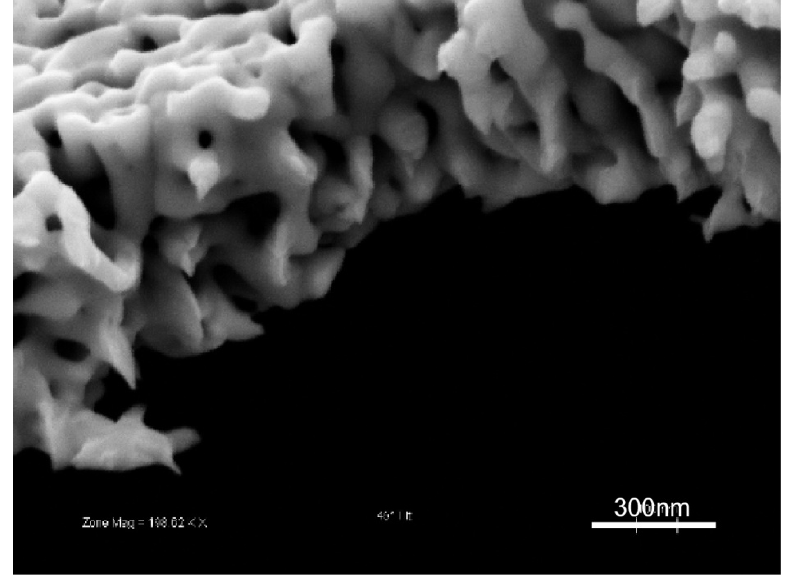
Figure 11. A high magnification SEM image of a fractured beam illustrating the ductile necking of ligaments. [Reproduced with permission from Acta Mater . 2007, 55 , 4593–4602. © 2007,